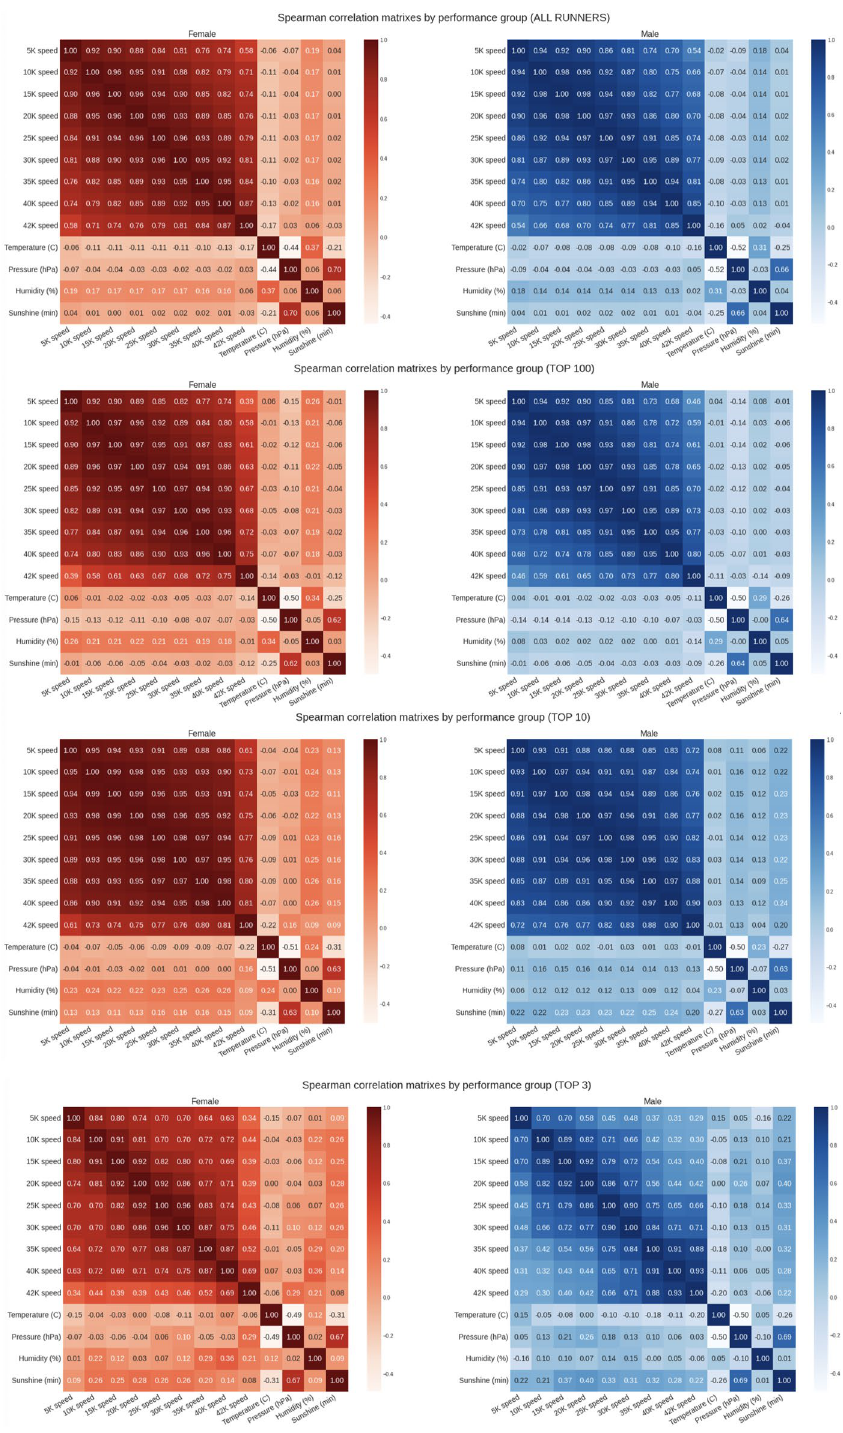
Figure 8. Spearman correlation matrixes by performance